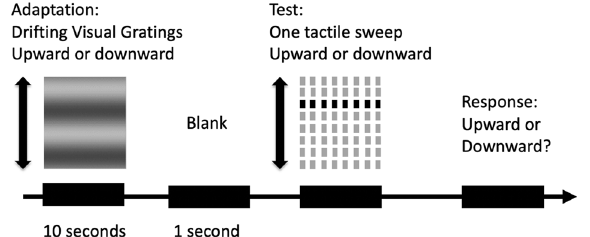
Figure 2. The experimental procedure in the visual-to-tactile condition. In each trial, a 10-s visual grating drifting either upward or downward was presented, followed by a period of 1 s blank and then a rapid target tactile sweep delivered to participants’ index fingertip of the right hand. The duration of the tactile sweep was determined by the staircase procedure. Participants were asked to judge the motion direction of the tactile sweep and press “U” for upward motions and “D” for downward motions.